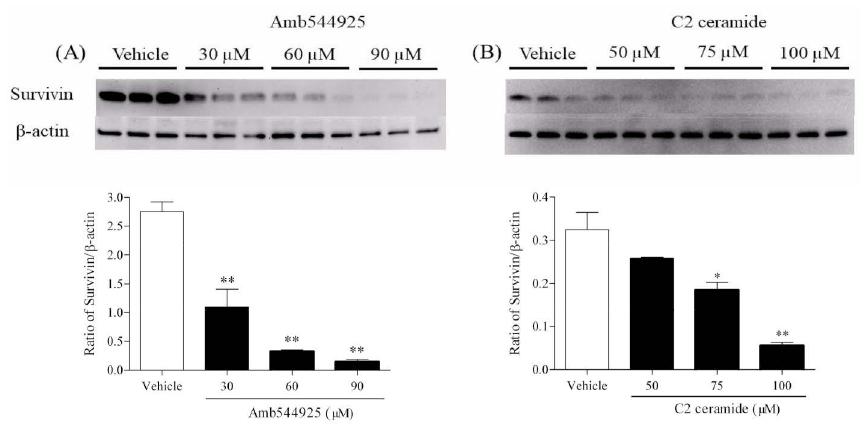
Figure 5. Effect of Amb544925 and C2 ceramide on survivin expression in HSC-3 cells. ( A ) Effect of Amb544925 on survivin expression in HSC-3 cells ( n = 3). Cells were preincubated with 30, 60 and 90 µ M Amb544925 for 8 h and then whole cell proteins were extracted. Representative immunoblots and densitometric analysis for survivin in lysates of HSC-3 cells treated with 30, 60 and 90 µ M Amb544925 for 8 h. Each column represents the densitometric measurement of survivin protein normalized to β -actin. The densitometric data are presented as the means ± SD ( n = 3). ** p < 0.01 compared to the vehicle control. ( B ) Effect of C2 ceramide on survivin expression in HSC-3 cells ( n = 3). Cells were preincubated with 50, 75 and 100 µ M C2 ceramide for 8 h and then whole cell proteins were extracted. Representative immunoblots and densitometric analysis for survivin in lysates of HSC-3 cells treated with 50, 75 and 100 µ M C2 ceramide for 8 h. Each column represents the densitometric measurement of survivin protein normalized to β -actin. The densitometric data are presented as the means ± SD ( n = 3). * p < 0.05 and ** p < 0.01 compared to the vehicle control.